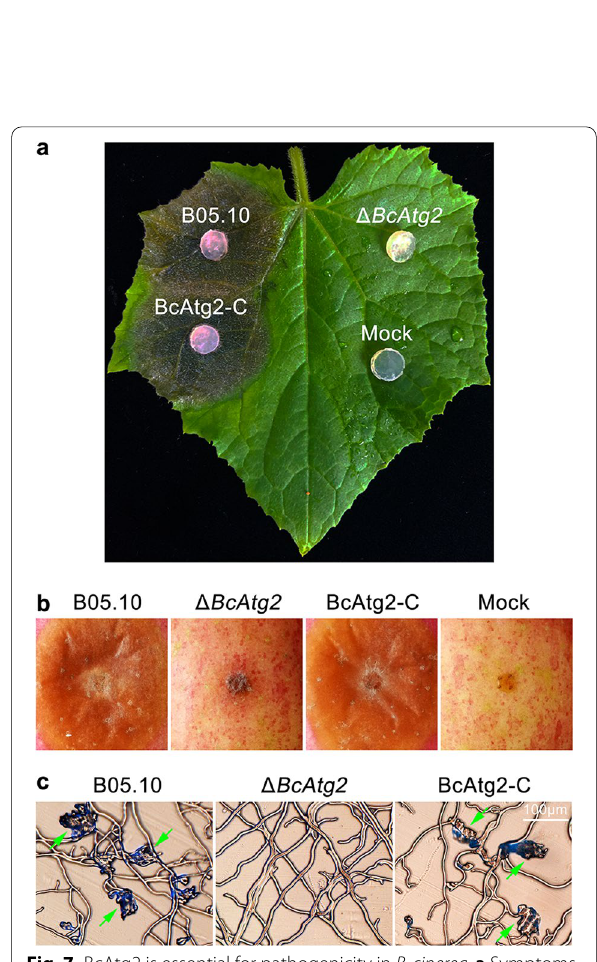
Fig. 7 BcAtg2 is essential for pathogenicity in B. cinerea . a Symptoms on cucumber leaves inoculated with mycelial plugs of the wild-type strain B05.10, the Δ BcAtg2 mutant and complemented strain BcAtg2-C for 3 days. b Symptoms on apple fruits inoculated with mycelial plugs of each strain for 3 days. c The infection structures formed by each strain in the early infection stage. Green arrows indicate infection structures